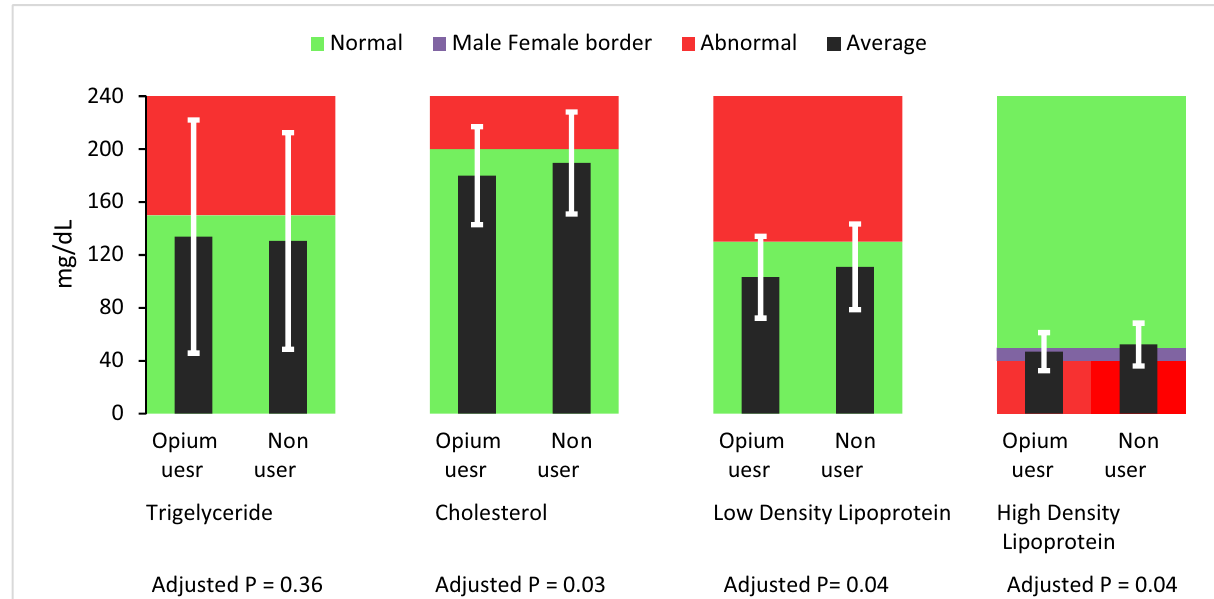
Figure 2. Comparison of lipid profile between opium user and non-user at the first of phase of PERSIAN cohort study. Lipid profile is presented with the mean—black bars—and standard deviation—white error bars—in mg/dL. The normal and abnormal ranges of lipid profiles are colored in green and red background. The border of the normal and abnormal HDL between the male and female subjects was also colored as purple background. The p-values came from a linear multivariable model that all variables having a correlation with lipid profile in univariate analysis with a p-value less than 0.2, were added to it. The p-value of the opium use variable in this model was reported as the Adjusted